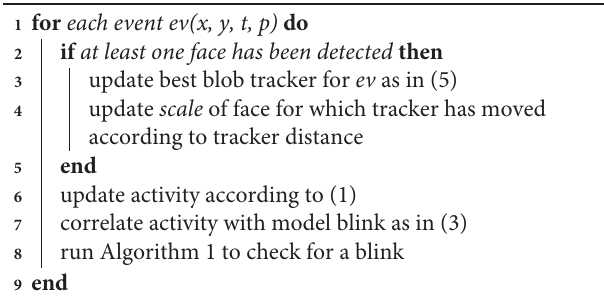
Algorithm 2: Event-based face detection and tracking